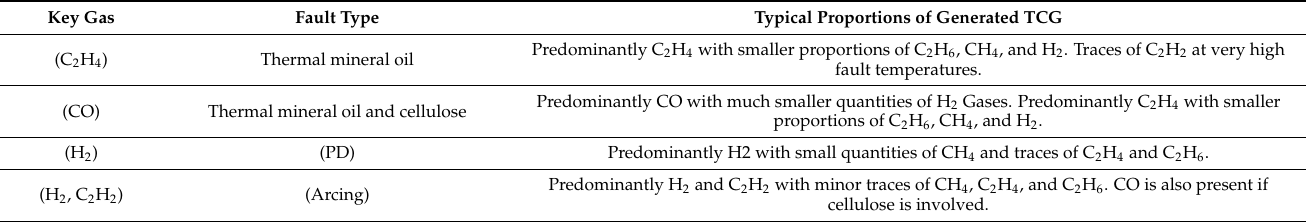
Table 1. Key Gas Method